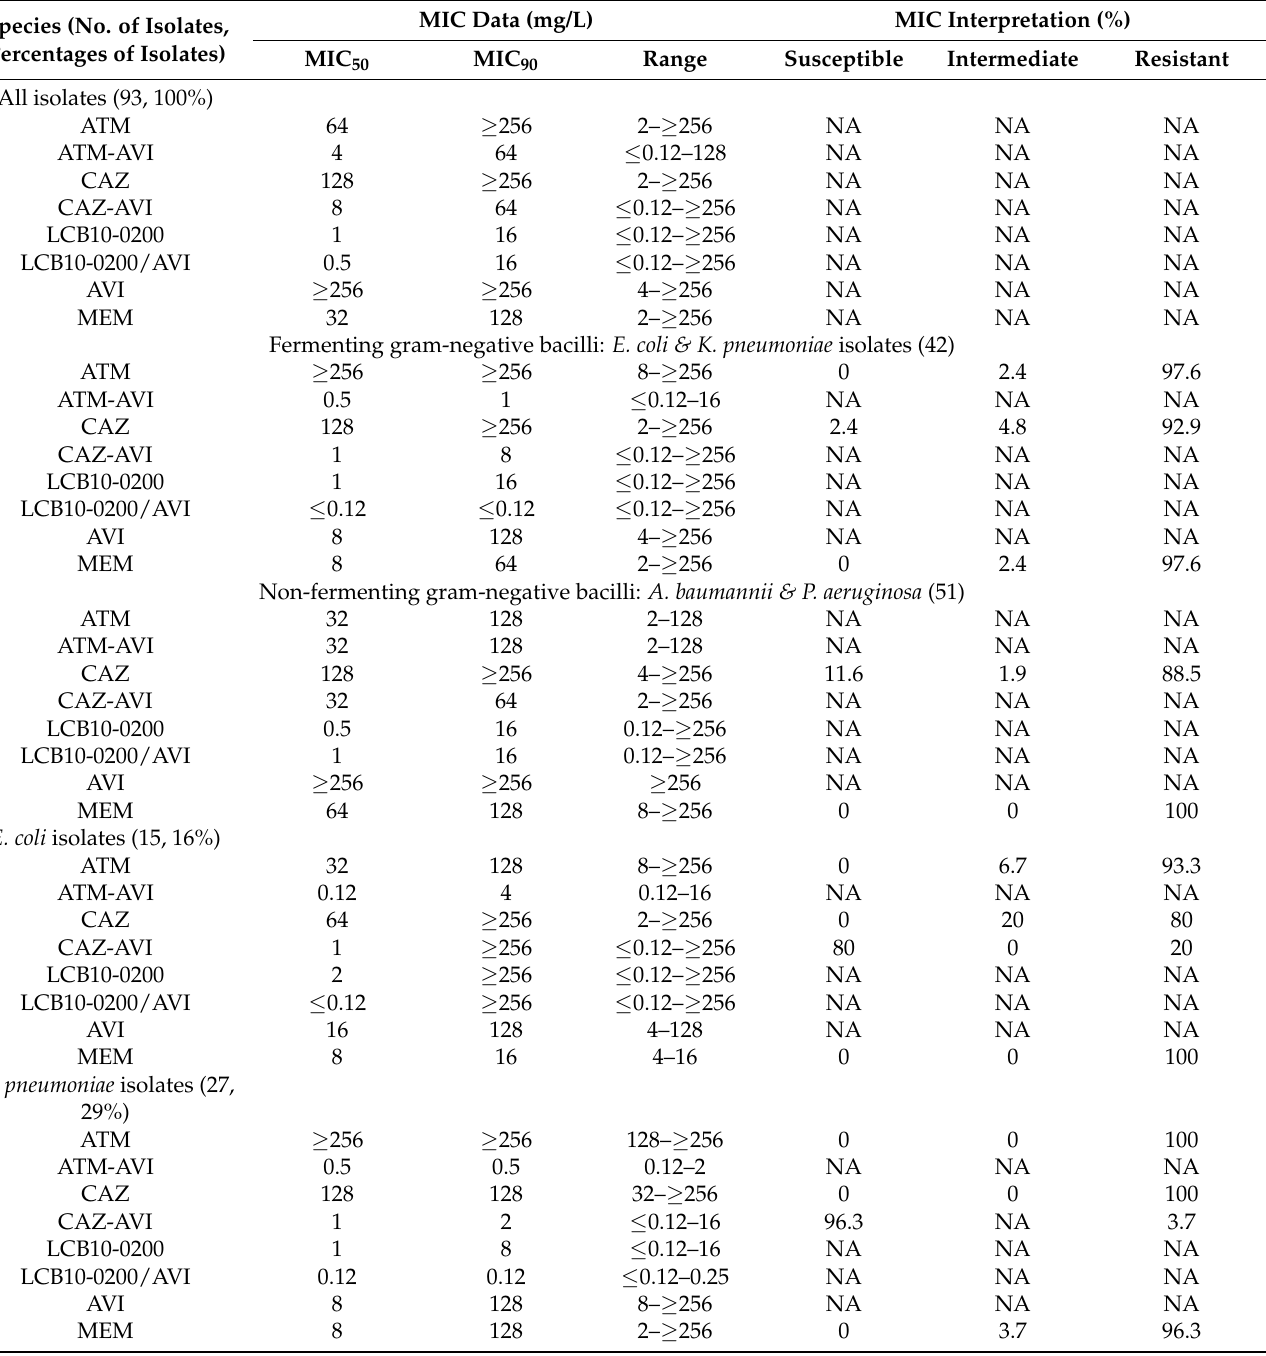
Table 1. MIC 50 , MIC 90 , MIC ranges, and interpretations of LCB10-0200, LCB10-0200/AVI, ATM, ATM-AVI, CAZ, CAZ-AVI, AVI against carbapenem-resistant E. coli , K. pneumoniae , A. baumannii , and P. aeruginosa . Species (No. of Isolates, Percentages of